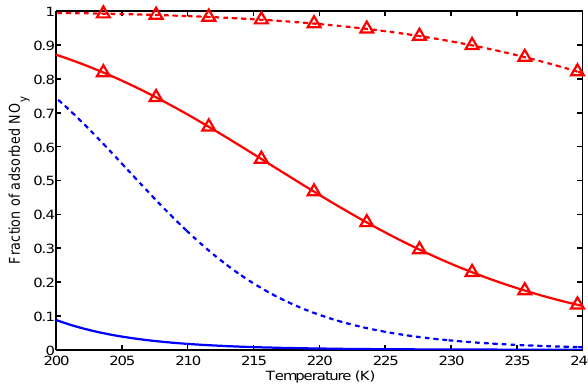
Fig. 6. Fraction of adsorbed HO 2 NO 2 (blue line) and HNO 3 (red line, triangles) to cirrus clouds at temperatures of the upper tropo- sphere. Solid lines represent clouds with a surface area density of 10 − 5 cm − 1 , dashed lines represent clouds with a surface area den- sity of 3 × 10 − 4 cm − 1 . Data for HNO 3 was taken from the IUPAC recommendations (Crowley et al., 2010), the data for HO 2 NO 2 is from this